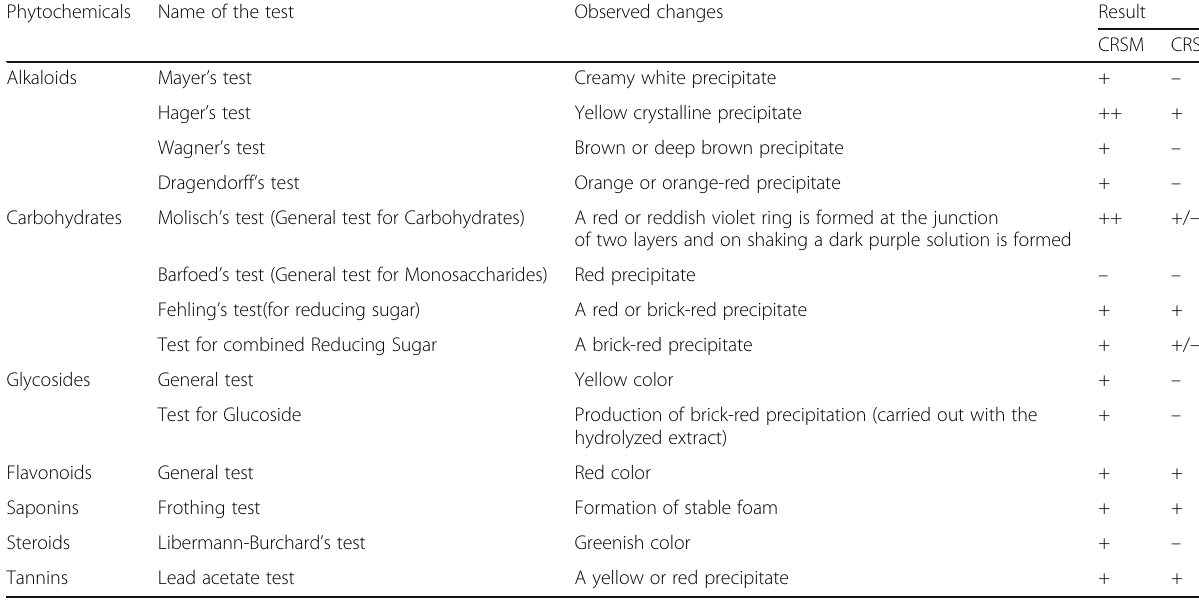
Table 1 Phytochemical constituents identified in the methanol and petroleum ether extracts of C. renigera seed extracts Phytochemicals